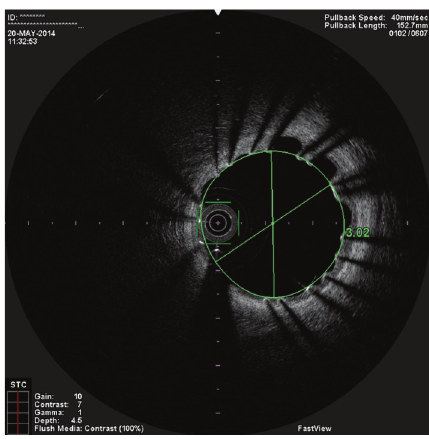
Figure 8: OCT performed after implantation of additional stents in medial and distal RCA and the balloon after